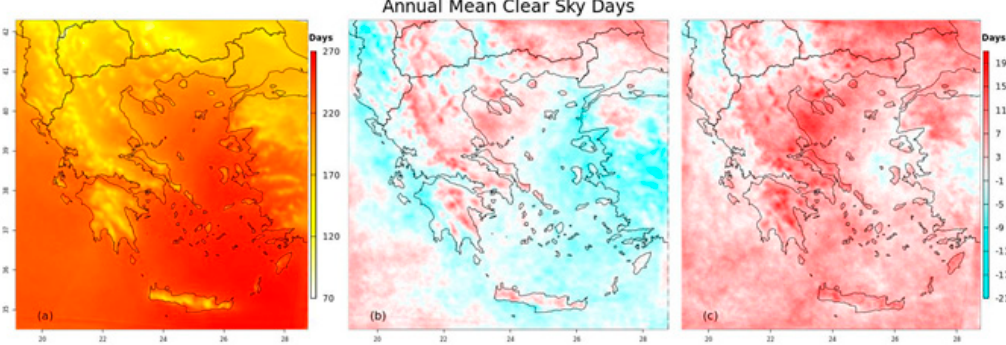
Figure 8. Mean annual clear-sky days of ( a ) historical period and changes with ( b ) RCP 4.5 and ( c ) RCP 8.5 scenarios.